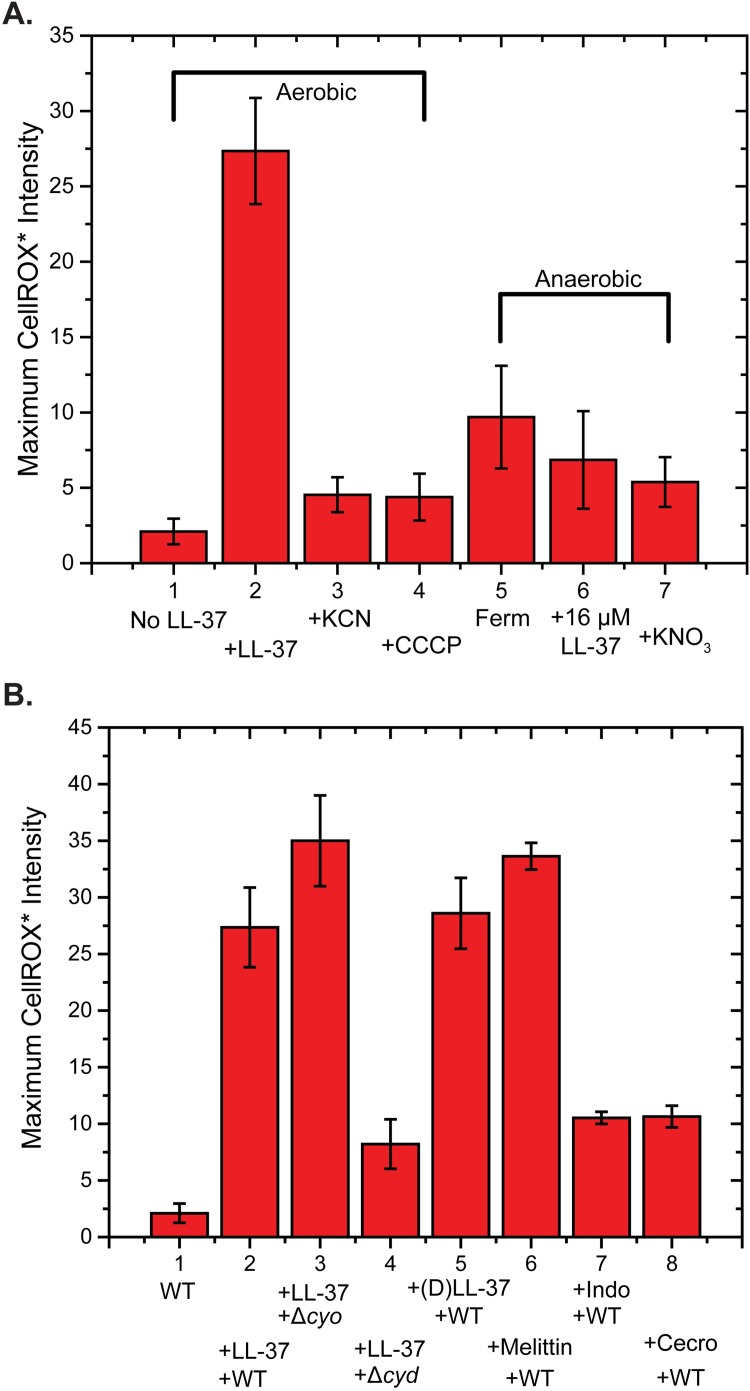
Comparison of average maximum CellROX* intensity over 30 min under different conditions.(A) (1) Normal aerobic growth (23 cells); no LL-37. (2) Addition of 4 μM LL-37 in aerobic conditions (58 cells). (3) Pre-treatment with KCN, followed by 4 μM LL-37 in aerobic conditions (62 cells). (4) Pre-treatment with CCCP, followed by 4 μM LL-37 in aerobic conditions (90 cells). (5) Addition of 4 μM LL-37 to cells growing in anaerobic, fermentation conditions (25 cells). (6) Addition of 16 μM LL-37 to cells growing in anaerobic, fermentation conditions (34 cells). (7) Addition of 4 μM LL-37 to cells growing in anaerobic conditions with respiration using NO3– (23 cells). In cases (2) and (6), the maximum intensity is that at the peak of the gradually rising and sharply falling signal, as in Fig 2B. In all other cases, the maximum is that of a slowly rising signal at t = 30 min, as in Fig 2D. (B) Comparison of average maximum CellROX* intensity over 30 min following addition of AMP as indicated. (1) Normal aerobic growth of WT MG1655 cells; no LL-37 (23 cells). (2) Addition of 4 μM LL-37 to WT MG1655 cells in aerobic growth (58 cells). (3) Addition of 4 μM LL-37 to ΔcyoABCDE MG1655 cells (cytochrome oxidase-bo3 deletion strain) in aerobic growth (50 cells). (4) Addition of 4 μM LL-37 to ΔcydAB MG1655 cells (cytochrome oxidase-bd deletion strain) in aerobic growth (29 cells). (5) Addition of 4 μM of the enantiomer (D)LL-37 to WT MG1655 cells in aerobic growth. (30 cells) (6) Addition of 10 μM melittin to WT cells in aerobic growth (42 cells). (7) Addition of 32 μM indolicidin to WT cells in aerobic growth (42 cells). (8) Addition of 0.9 μM cecropin A to WT cells in aerobic growth (49 cells).